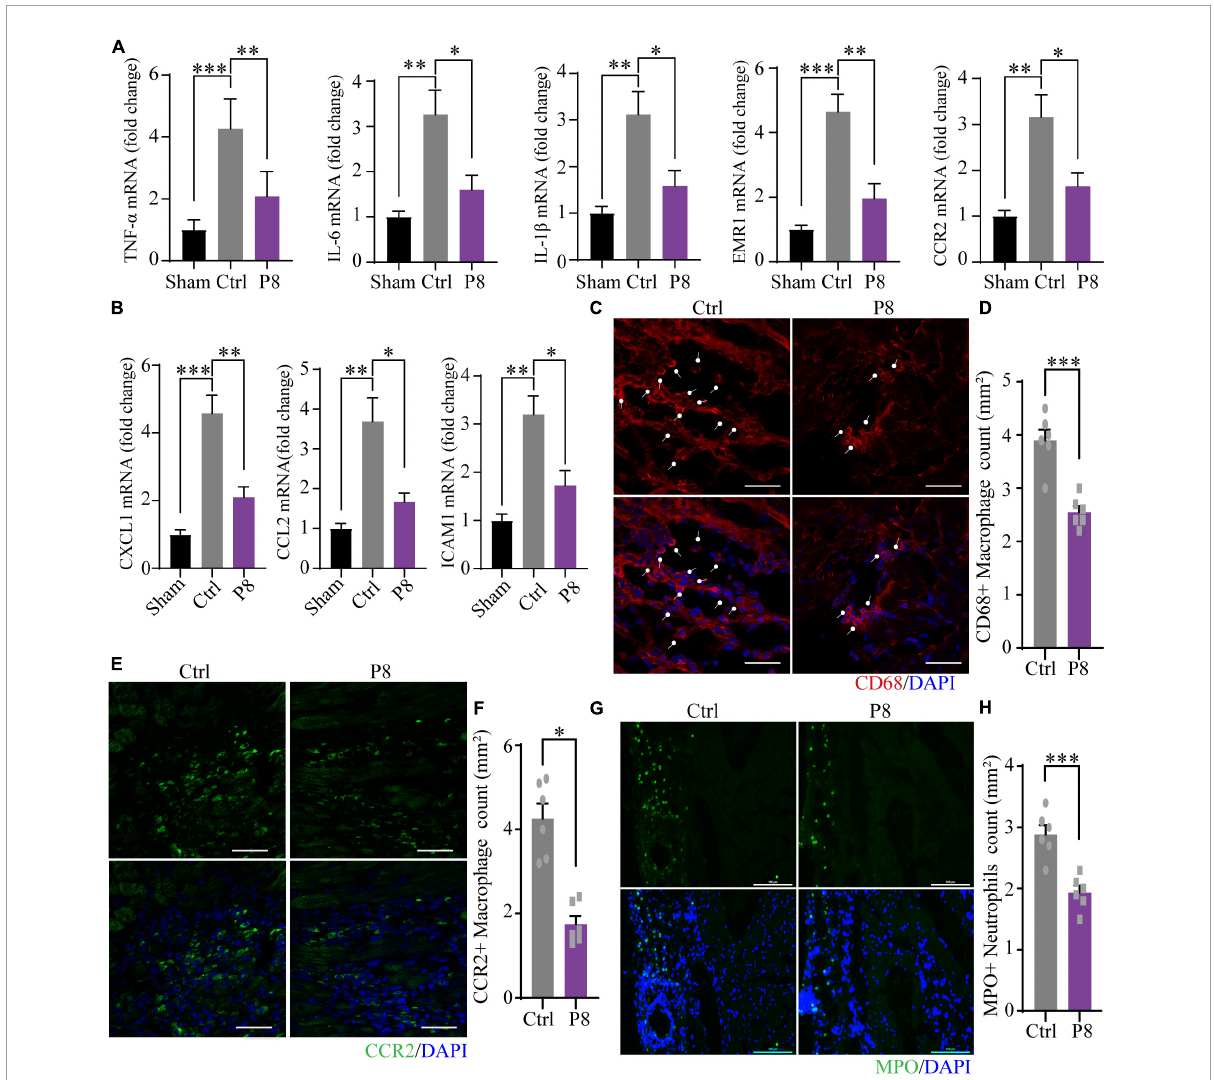
FIGURE6 P8 attenuates inflammatory response of heart tissues in the border zone in the infarct border area of mice. (A) Real-time PCR analysis of proinflammatory molecules mRNA expressions in border zone of myocardial infarction mice after 3 days with or without P8 administration ( n = 3 mice). (B) mRNA expression of inflammation-related genes (CXCL-1, CCL2, ICAM1 and VCAM1) in border zone of myocardial infarction mice after 3 days with or without P8 administration, as determined with by real-time PCR ( n = 3 mice). (C,D) Immunofluorescence staining and quantitative analyses of heart sections with CD68 antibody. (E–H) Representative immunofluorescence images and statistical analysis of with CCR2 (E,F) and MPO antibodies (G,H) of infarct margin area of heart tissue 3 days after MI. Scale bar: 100 µ m. * p < 0.05; ** p < 0.01; *** p <